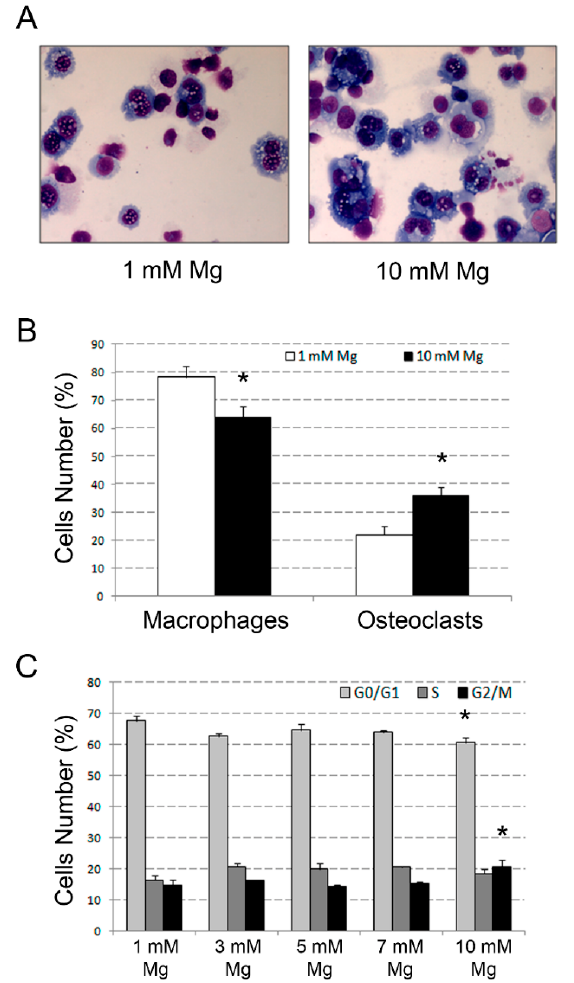
Figure 2. Changes in morphology and proliferation rate in U937 cell-derived osteoclasts after exposure to supra-physiological Mg concentrations. U937 cells, under the experimental conditions described in Figure 1, were subjected to morphological analysis, performed by microscopic examination of May–Grünwald Giemsa-stained cytospins, and cell-cycle assessment, carried out by flow cytometry analysis of propidium iodide (PI)-stained cell suspensions. Panel A shows a couple of representative microscopic fields obtained with 1 and 10 mM Mg. The histogram presented in Panel B indicate the percentages of macrophages and osteoclasts detected in the same cell samples and relative statistical analysis. Histograms presented in Panel C indicate cell-cycle distribution and relative statistical analysis elicited by exposure to scalar concentrations of Mg ranging from 1 to 10 mM. Data are reported as means ± SEM values of a triplicate experiment. Asterisks indicate statistically significant results. Table 1. Effects of phorbol 12-myristate 13-acetate (PMA)/vitamin D 3 (VD3) on the total Mg intracellular concentration. Measurements were carried out in U937 cells incubated with 1 and 10 mM Mg, in the absence (control) or presence of PMA/VD3 (treated). Cells were sonicated and the Mg concentration determined using the fluorescent probe diaza-18-crown-6-hydroxyquinoline (DCHQ5). Data are reported as means ± standard error of the mean (SEM) values of a triplicate experiment. Mg Extracellular